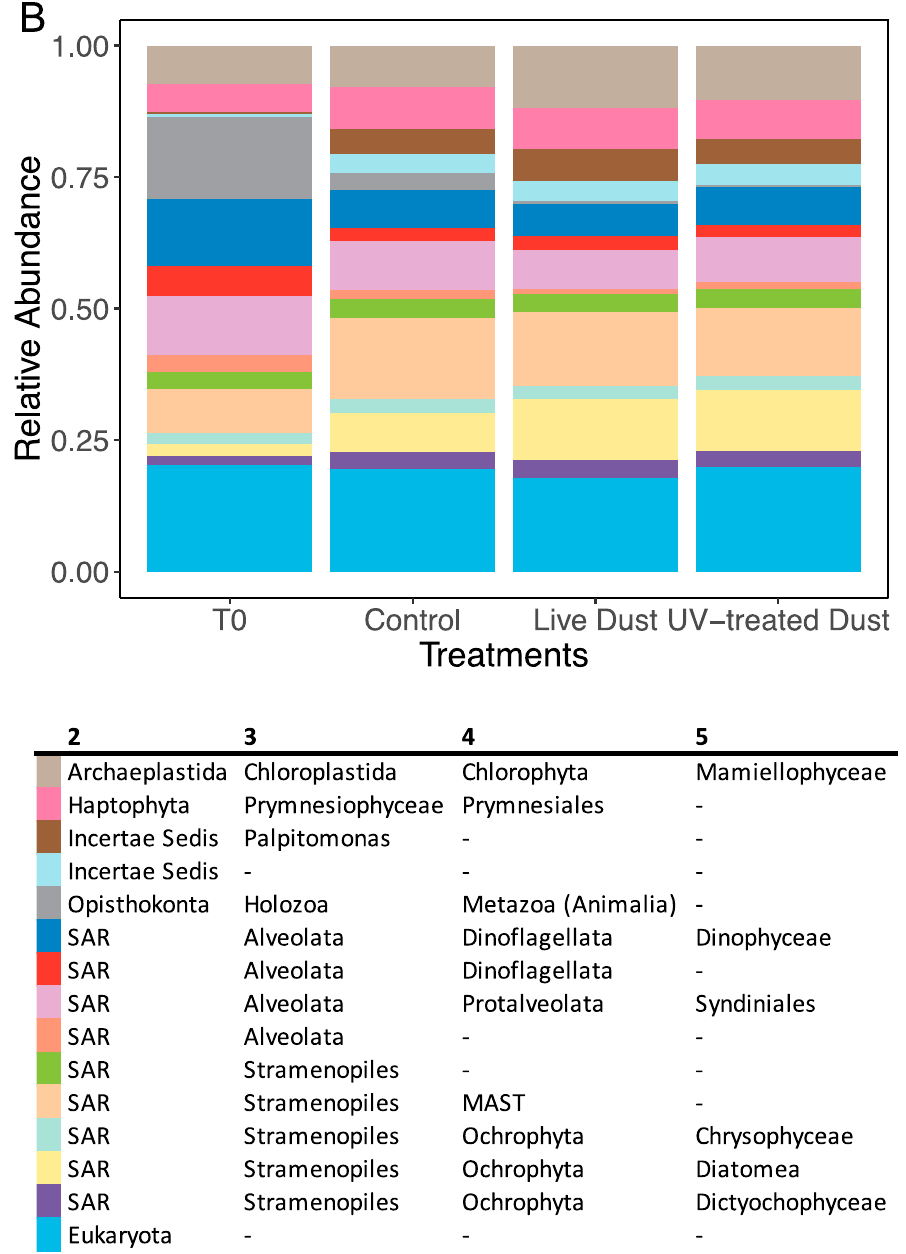
Figure 5. Relative abundance of prokaryotes ( A ) and eukaryotes ( B ) in the NRS surface water before amendment (T0) and 44 h after amendment for control, live dust, and UV-treated dust treatments. Data shown are the sum of triplicates. The last row in both legends is the sum of all rare taxa (constituting < 5% of relative abundance). In ( A ), A and B in the first column of the legend corresponds to archaea and bacteria, respectively. In ( B ), column names 2–5 represent taxonomic levels.